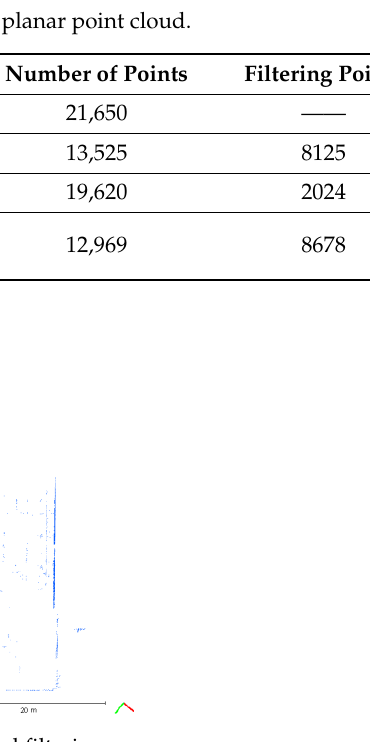
Figure 8. Handheld LiDAR point cloud after point cloud